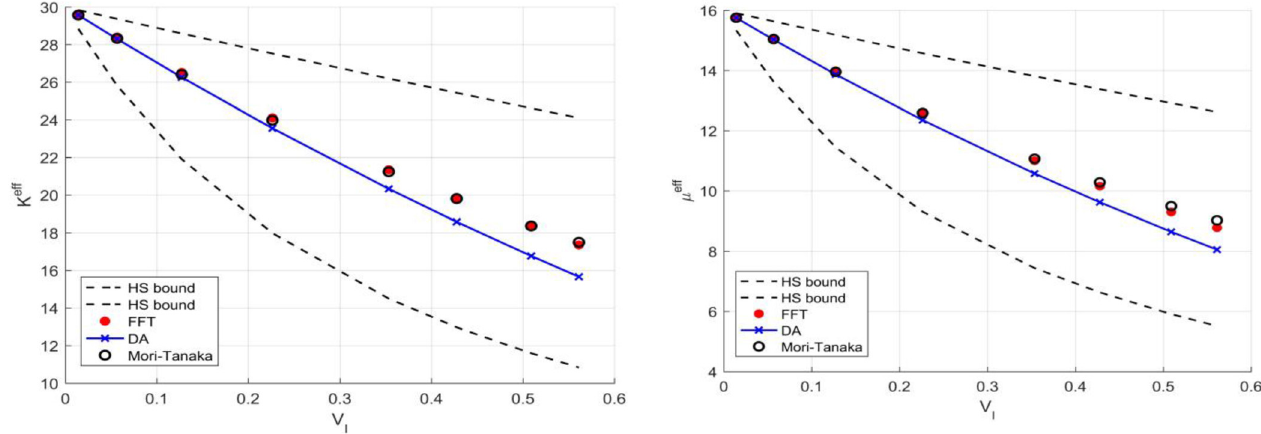
Fig. 4. Elastic bulk (left) and shear modulus (right) of three-phase composites with the case (C). Table 1. Comparison of results ( K eff ) of FFT, MTA, DA, and HS bound for the case (A), R 1 ¼